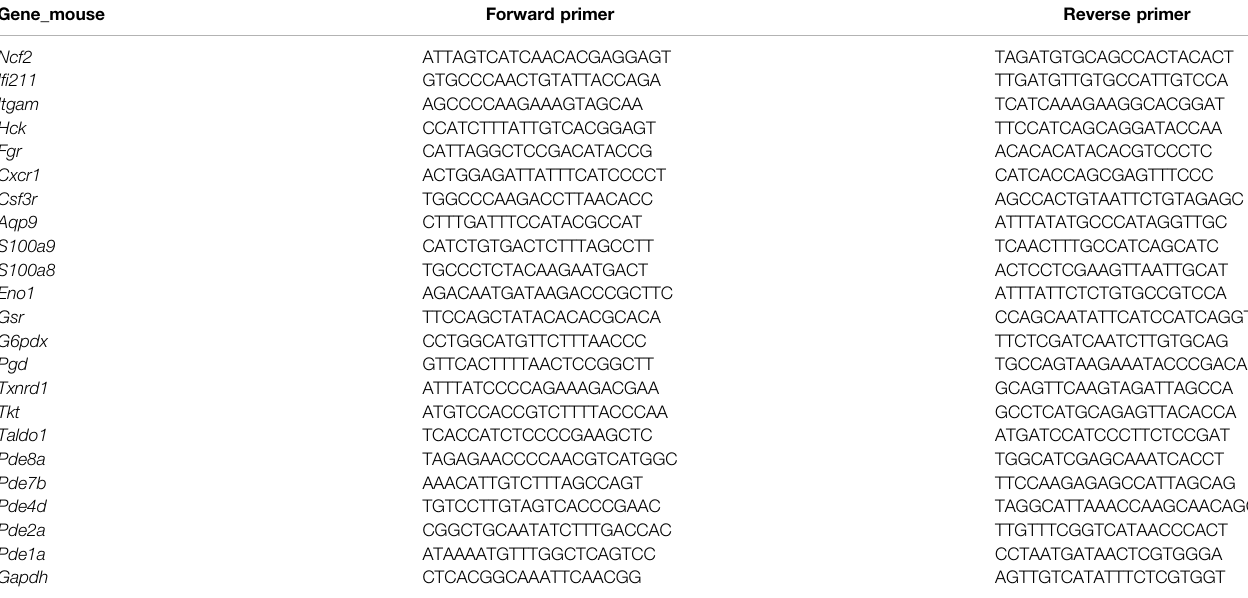
TABLE 1 | Primers for the hub TRGs to be validated by RT-PCR in mouse lungs of hypoxia-induced PH. Gene_mouse Forward